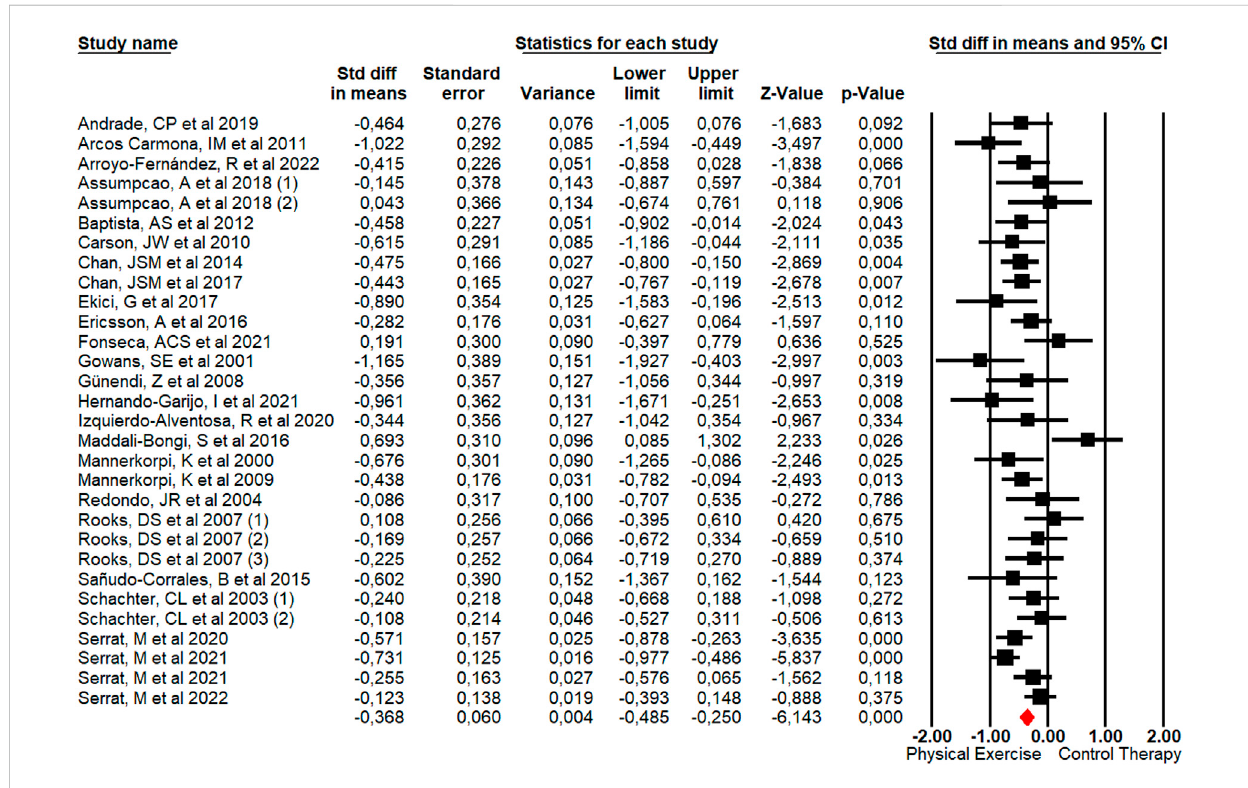
FIGURE 5 Forest Plot of the immediate effect of PEBT on